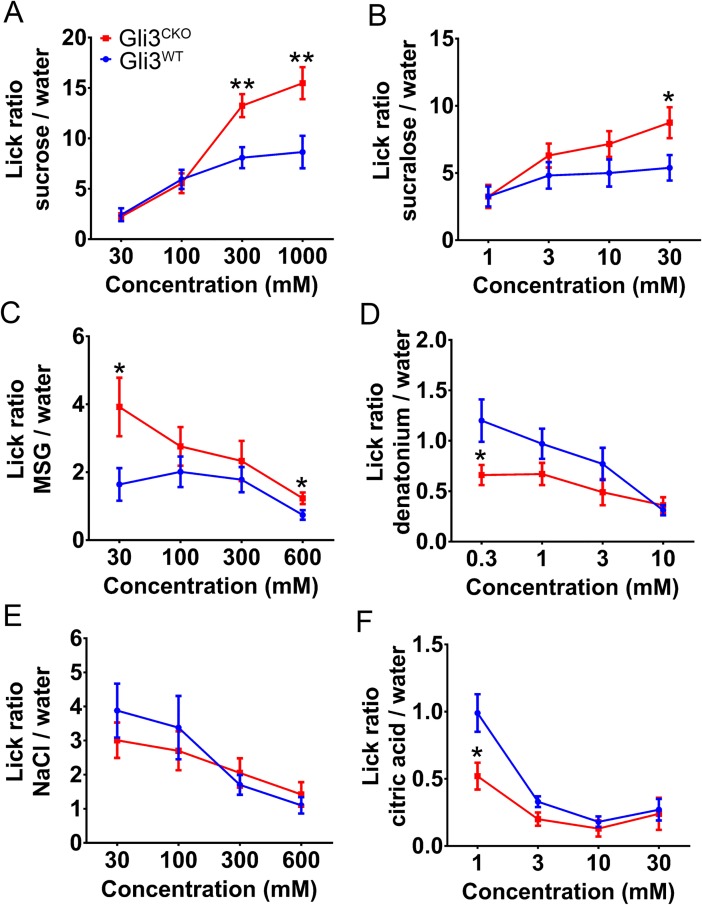
Gli3-deficient mice exhibit increased behavioral responses to sweet, umami, and bitter tastants.Brief-access tests were used to measure behavioral responses to sweet (sucrose and sucralose, A and B), umami (monosodium glutamate [MSG], C), bitter (denatonium, D), salty (NaCl, E), and sour (citric acid, F) taste stimuli. Compared to Gli3WT mice, Gli3CKO mice display increased lick responses over a range of concentrations to the appetitive stimuli (sucrose, sucralose, and MSG) and decreased lick responses to the aversive stimuli (denatonium and citric acid). Lick ratios were calculated by dividing the number of licks to a taste solution by the number of licks to water in each test session. Data are means ± SEM Statistically significant differences were determined by repeated two-way ANOVA test [sucrose: F (1, 119) = 13.07, P<0.05; sucralose: F (1, 159) = 9.76, P<0.05; MSG: F (1, 119) = 8.69, P<0.05; denatonium: F (1, 123) = 5.40, P<0.05; NaCl: F (1, 147) = 1.57, P>0.05; citric acid: F (1, 127) = 5.45, P<0.05] and post hoc t-test (n>12, *p<0.05, **p<0.01).